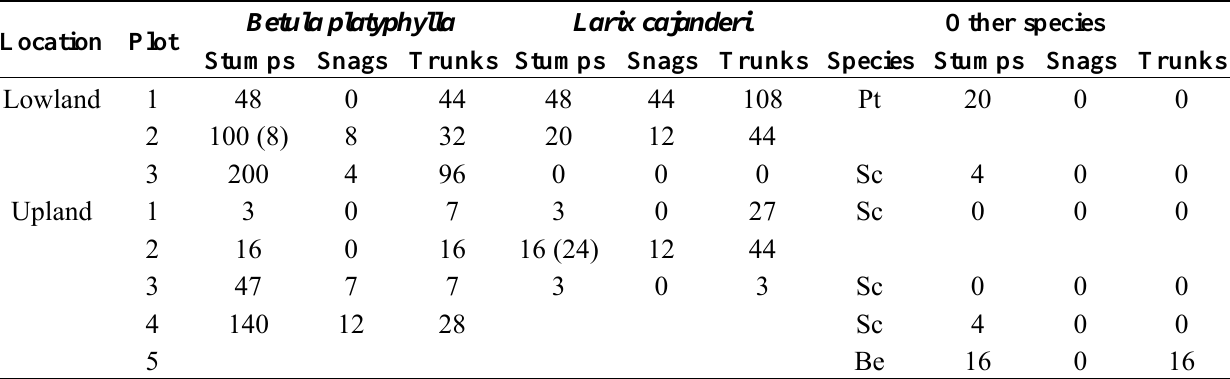
Table 4. Dead wood within old-growth forest plots in Central Kamchatka (numbers/ha). Tips are included in brackets with stumps. Snags are defined as dead trees with stems broken above 1.3. Trunks are identifiable fallen trees >5 cm dbh on the forest